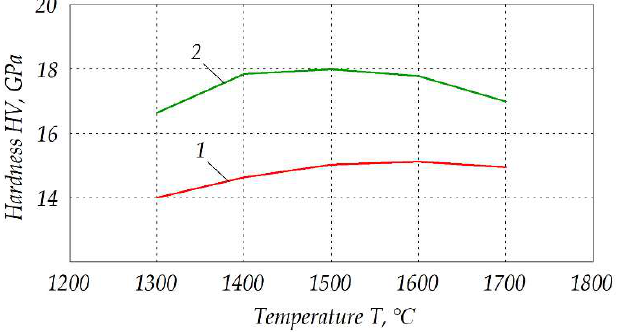
Figure 14. Microhardness of the composite Al 2 O 3 —20 wt.% SiO 2 —10 wt.% ZrO 2 sintered at different temperatures: 1 —traditional sintering, 2 —electroconsolidation.